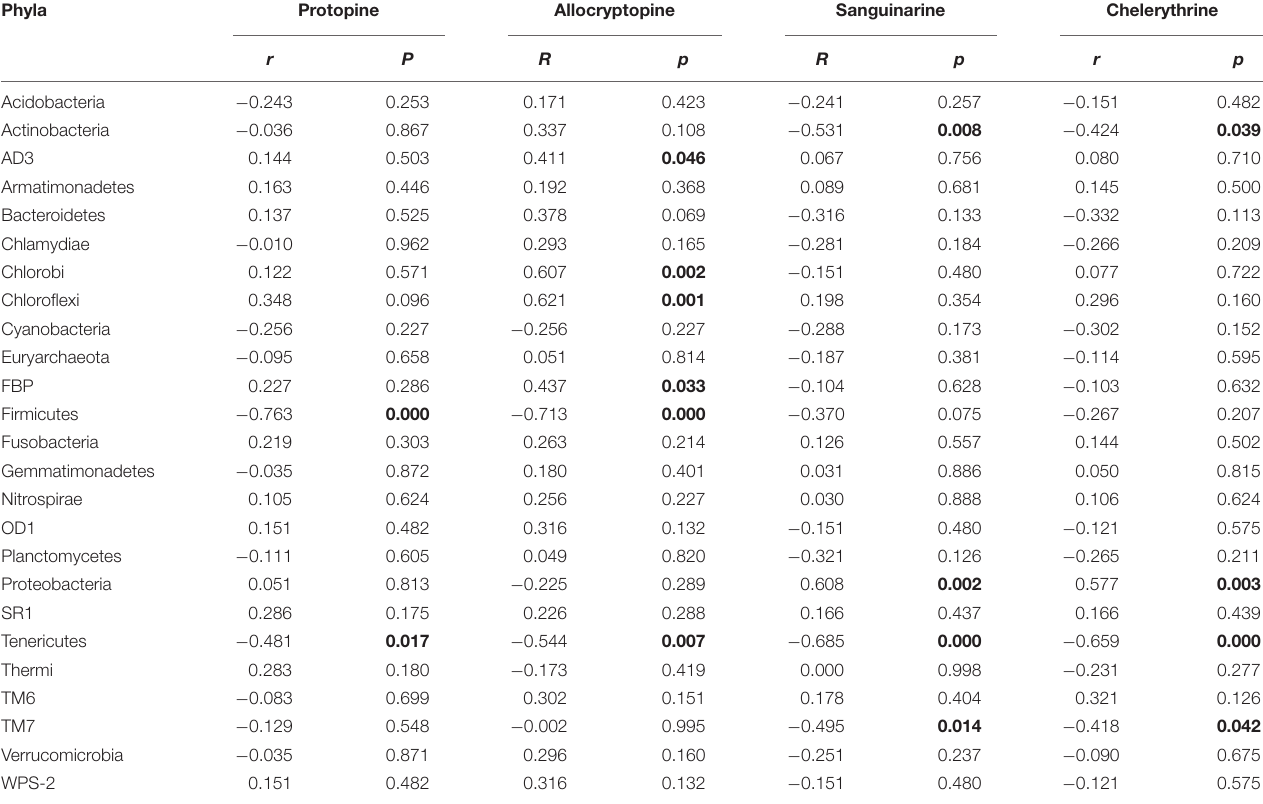
TABLE 2 | Spearman Correlation coefficients showing the relationships between endophytic bacterial phyla and four alkaloids. Phyla Protopine Allocryptopine Sanguinarine